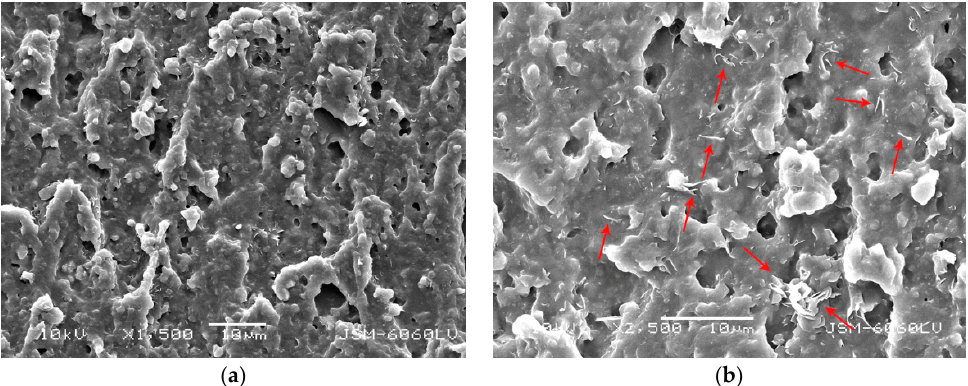
Figure 15. SEM images of EPDM plate samples after swelling in methoxypropanol: ( a ) 10× UV treatment, ( b ) 30× UV treatment.